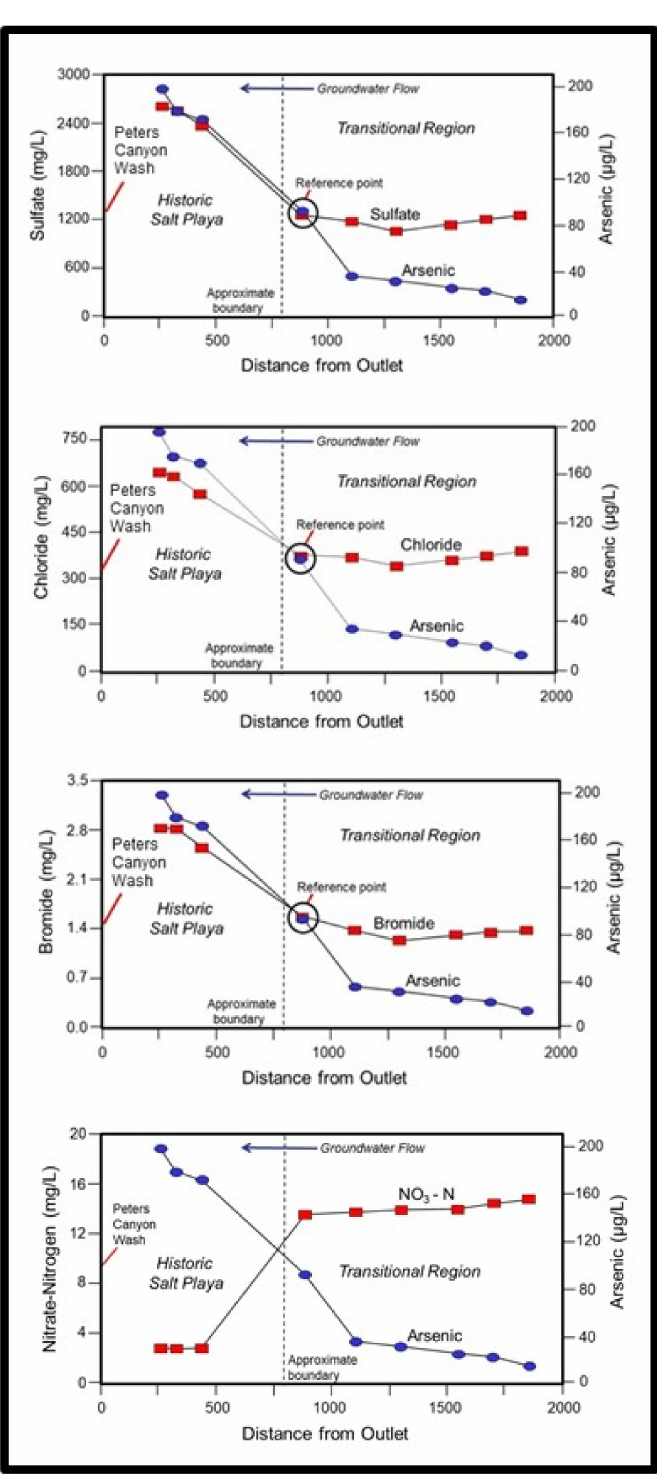
Figure 10. Graphs showing concentrations of sulfate and arsenic, chloride and arsenic, bromide and arsenic, and nitrate and arsenic in groundwater sampling points at Edinger Drain. The reference point is calibrated on the axis scale so the points overlap directly for the ions on the relative axes right above the salt flats (dashed line). As groundwater flows through the alkali flats region (left of dashed line), sulfate, chloride, bromide, and arsenic increase in a proportional manner, whereas nitrate decreases sharply in concentration. Evaporative enrichment of arsenic and salts of sulfate, chloride, and bromide is implied in the alkali salt flats